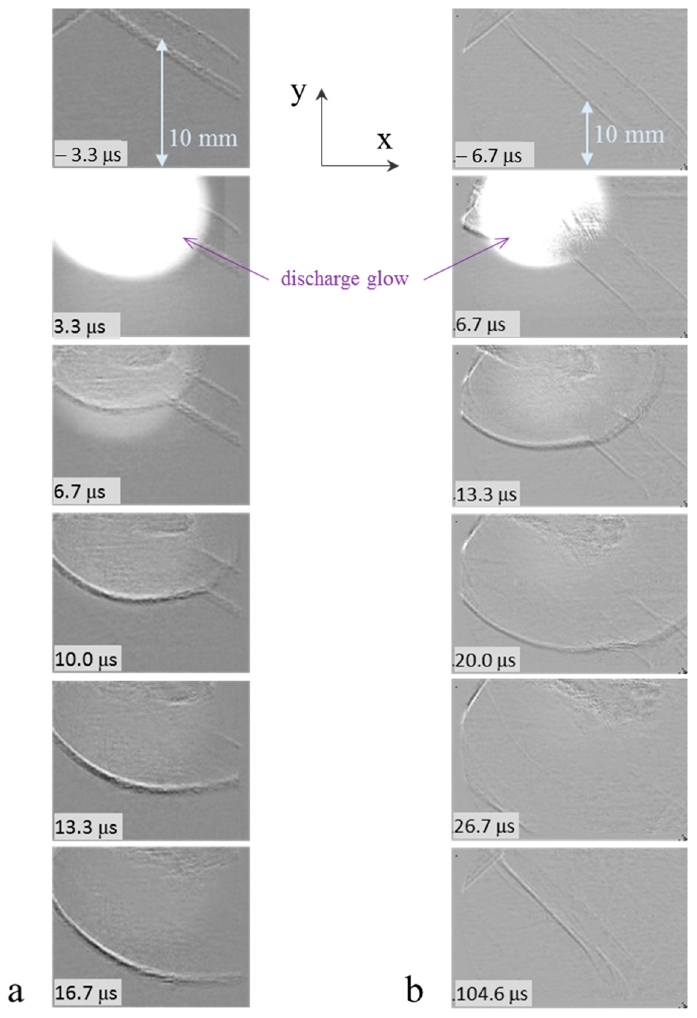
Figure 6. The sequences of shadowgraph images of the flow field after the discharge at flow Mach number 1.27 and 0.14 kg/m 3 density ( a ) and at Mach number 1.30 and 0.11 kg/m 3 density ( b ). The zero-time corresponds to the discharge initiation. The flow is from left to right.